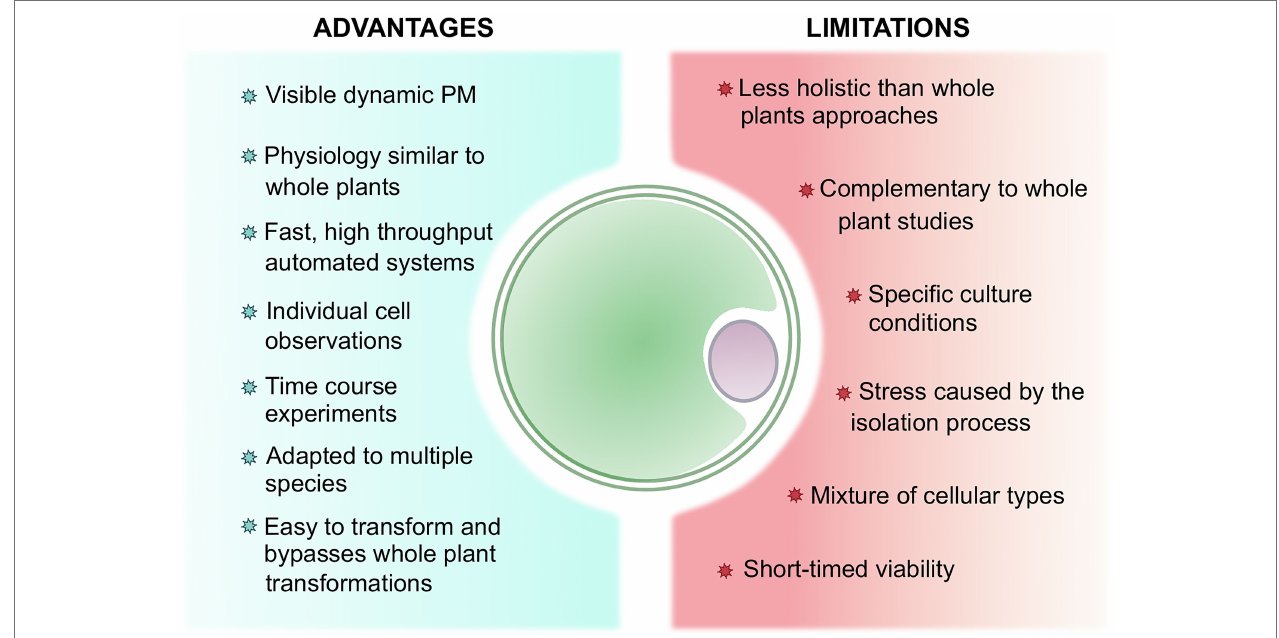
FIGURE 3 | Summary of the advantages and limitations of working with protoplasts to study plant stress perception and response comparatively to whole